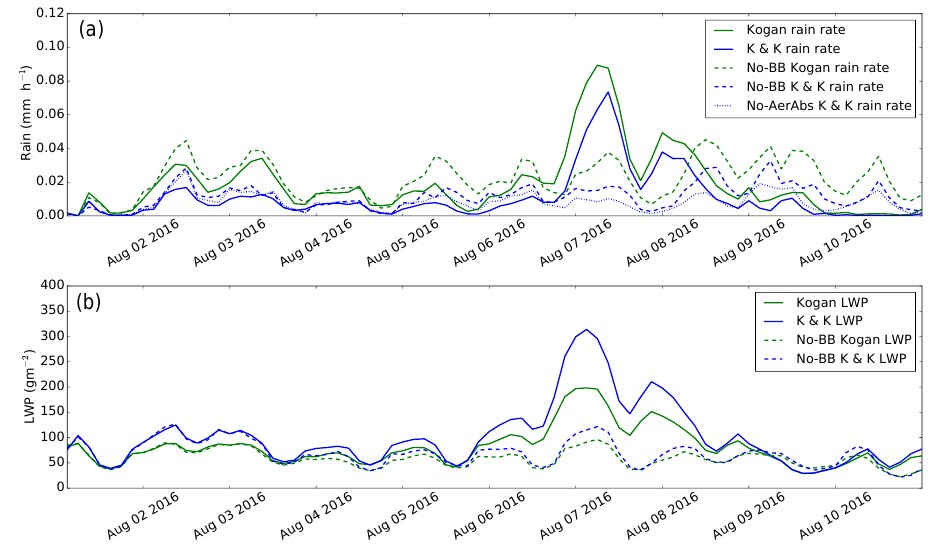
Figure 14. Domain mean precipitation rates (a) and liquid water path (b) in the regional model with and without biomass burning emissions, with the alternative parameterisations of autoconversion and accretion from (Kogan, 2013) and from (Khairoutdinov and Kogan, 2000) (labelled K &